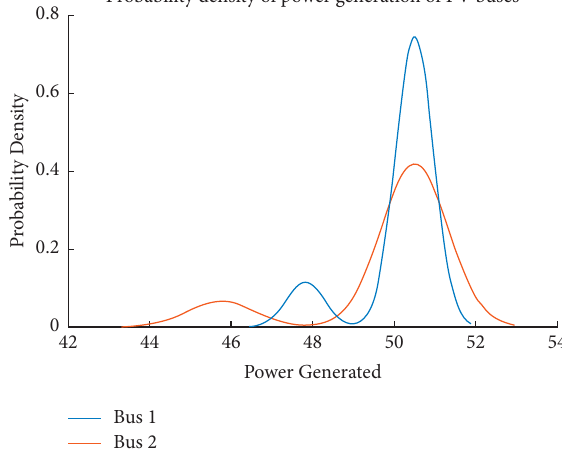
Figure 8: Power density distribution at buses 1 and 2.